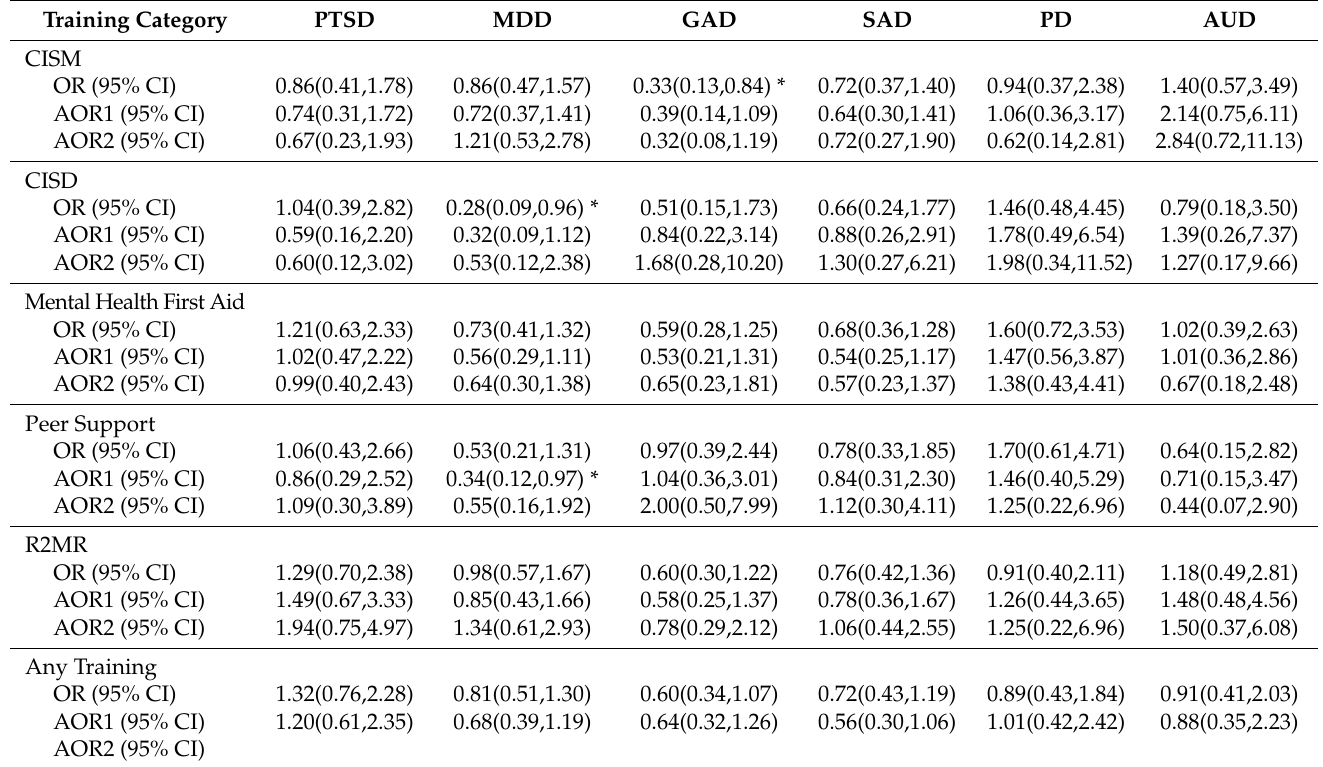
Table 4. Associations between screening positive for mental disorders among individuals who have had different mental health training